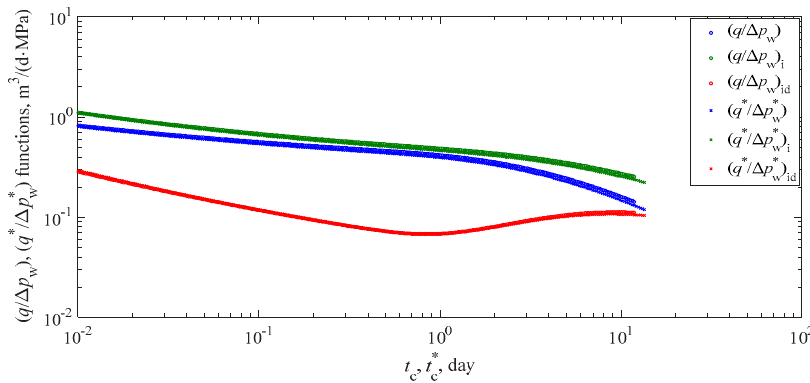
Figure 11. Production data for CRP cases with different values of flow rate q .